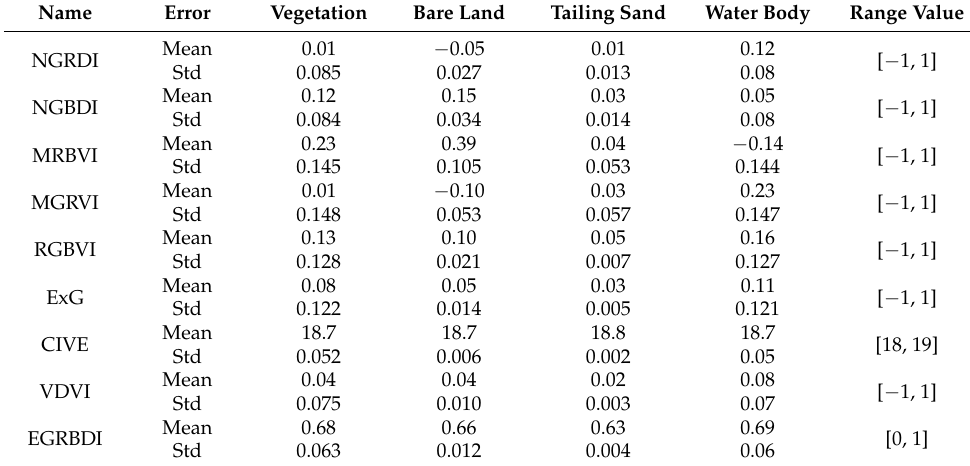
Table 3. Error statistics of four land types of VI.